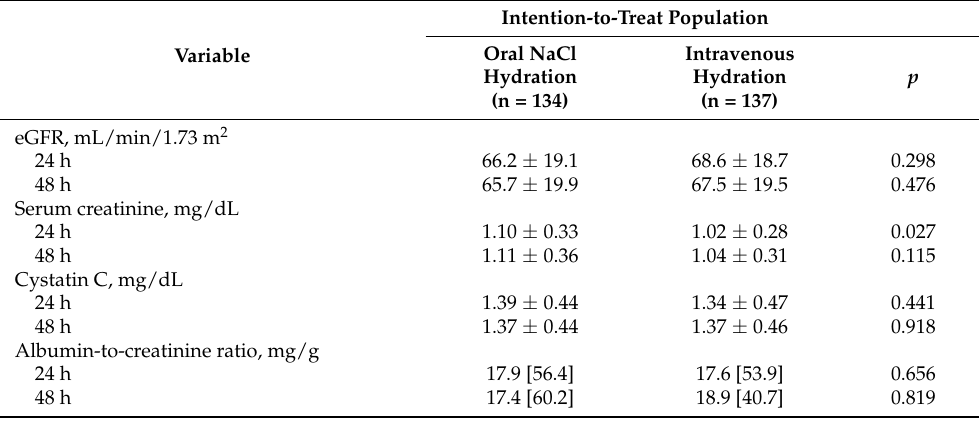
Table A3. Differences in continuous efficacy assessments between oral- and intravenous-hydration groups within the 48-h follow-up period in the intention-to-treat